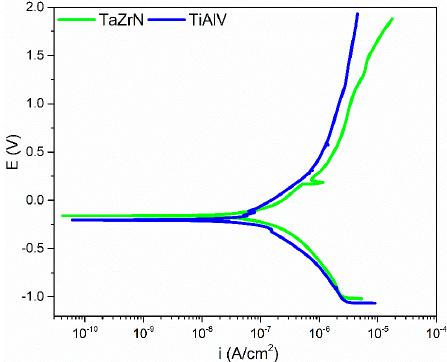
Figure 5. Potentiodynamics curves of TaZrN film and TiAlV substrate.